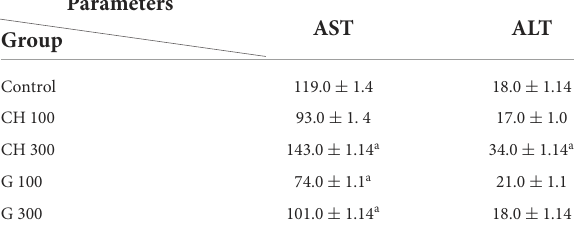
TABLE 3 Effect of chemical and green TiO 2 NPs on liver transaminases of control and experimental groups (mean ± SD). Parameters Group